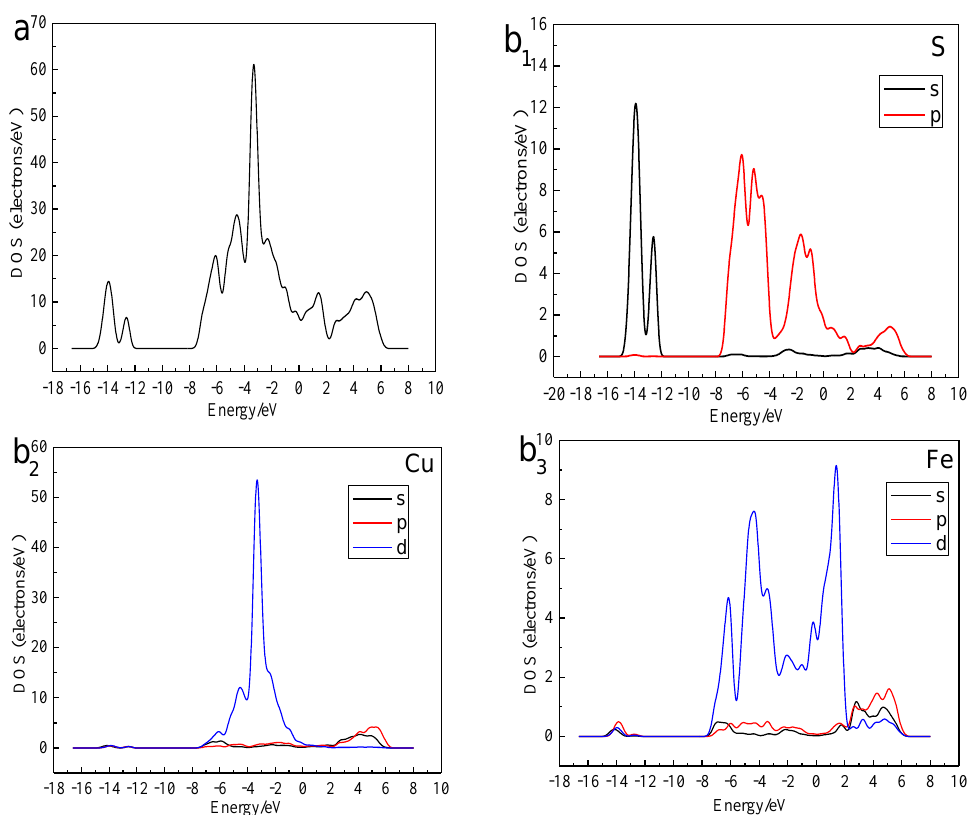
Figure 3. DOS and PDOS of bornite in DFT calculation (CASTEP module of Materials Studio 6.0 software package, PBE density function, Hubbard + U correction): ( a ) Total; ( b 1 ) Cu; ( b 2 ) Fe; ( b 3 ) S.